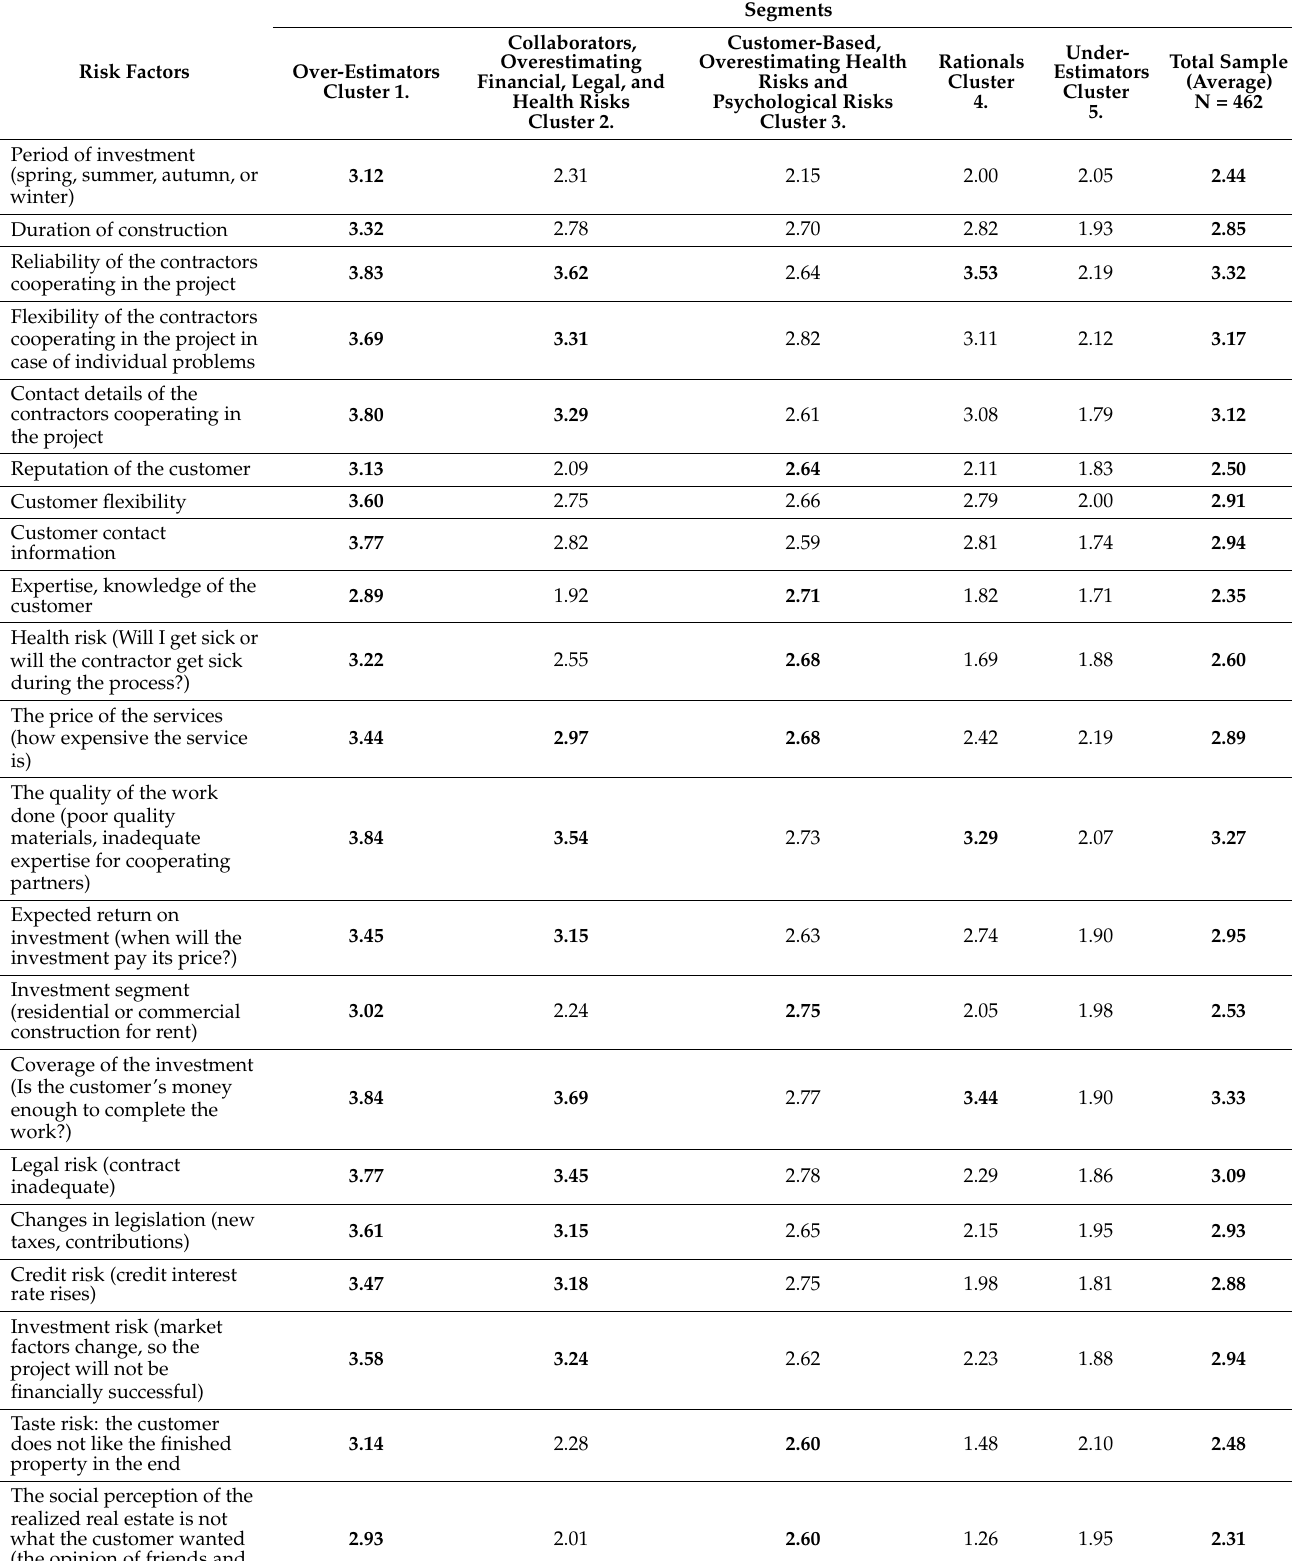
Table 7. Contractor segments by perceived risk factors (mentions are in %). Source: authors’ own research, 2018. N = 462